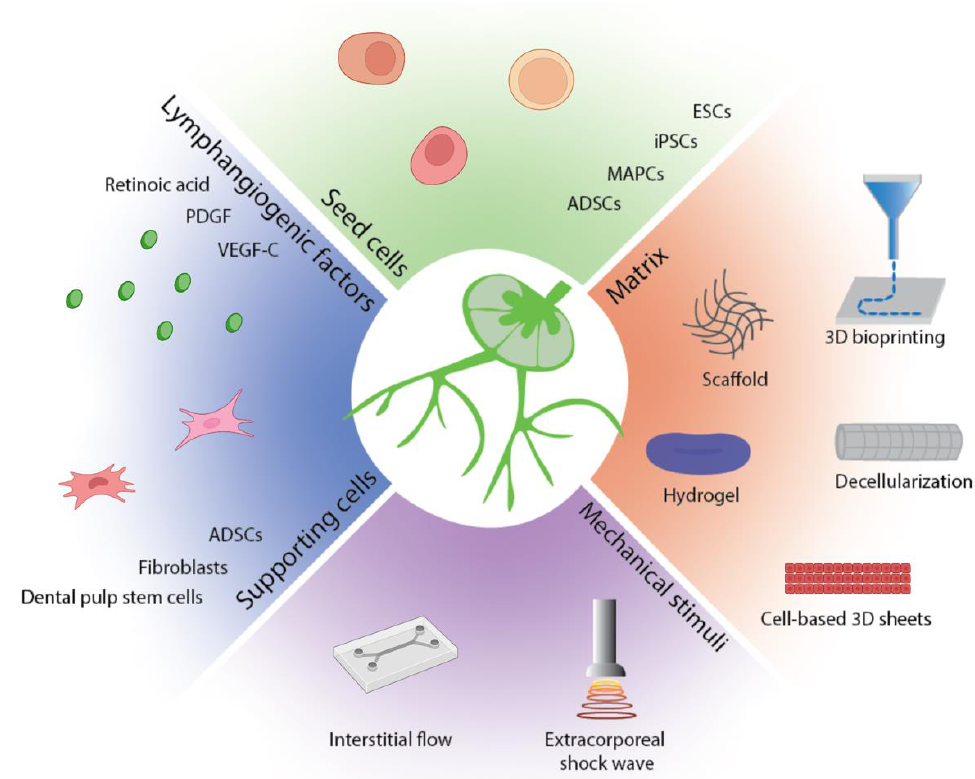
Figure 2. Summary of lymphatic tissue bioengineering strategies. Functional lymphatic tissues can be engineered with seed cells and supporting cells, pro-lymphangiogenic factors, and mechanical stimuli in an appropriate matrix.